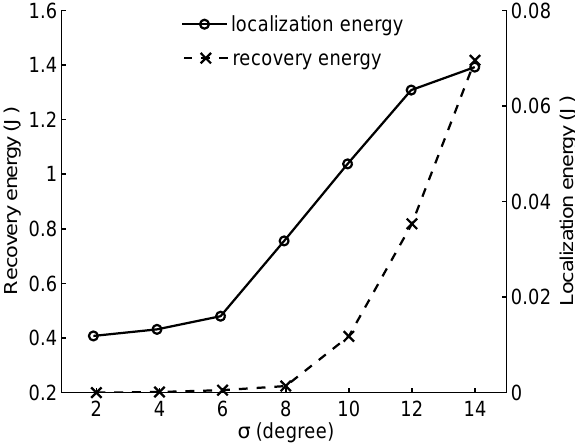
Figure 13 . Impact of sensor node observation standard deviation on energy